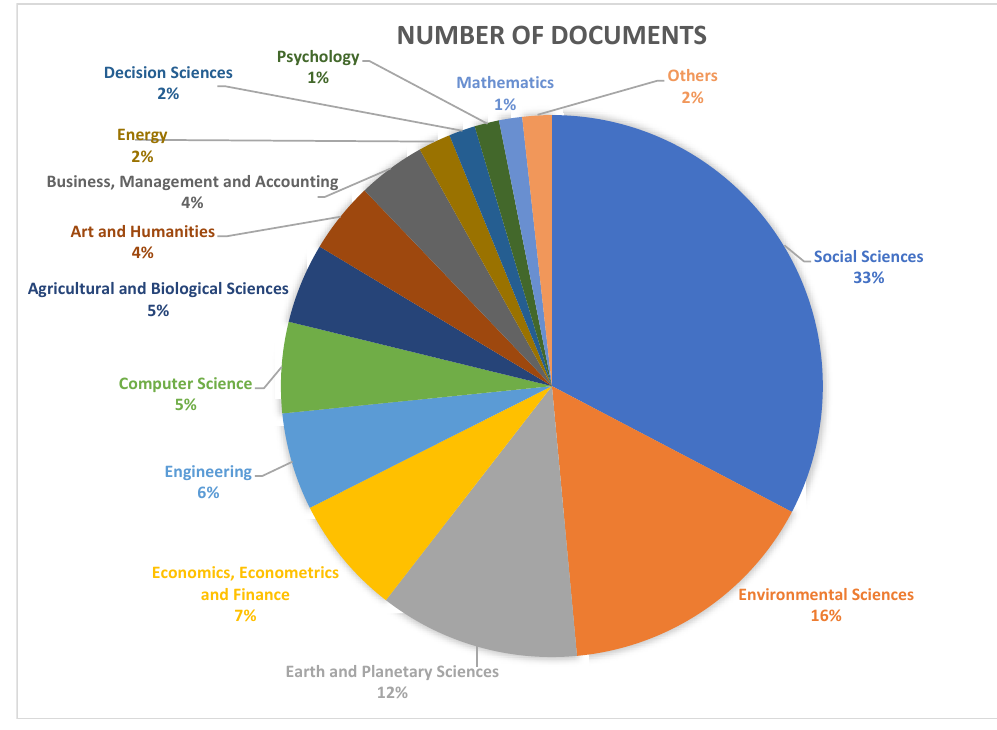
Figure 3. Structure of published items in the Scopus database, 30 April 2020, keywords spatial exploration, economic data, education, regarding the research area. (Source: Authors’ research, based on Scopus data).